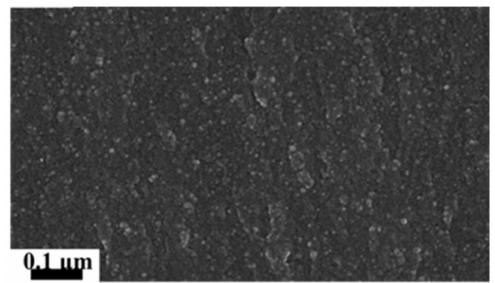
Figure 13. SEM of ZA2 composite coatings.